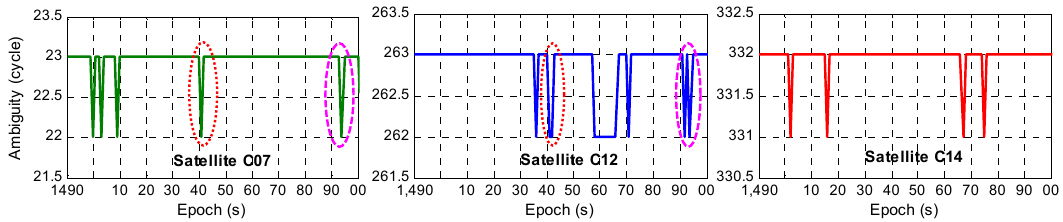
Figure 7. Fixed ambiguity from the 1490th to the 1600th epoch for satellites C07, C12, and C14.